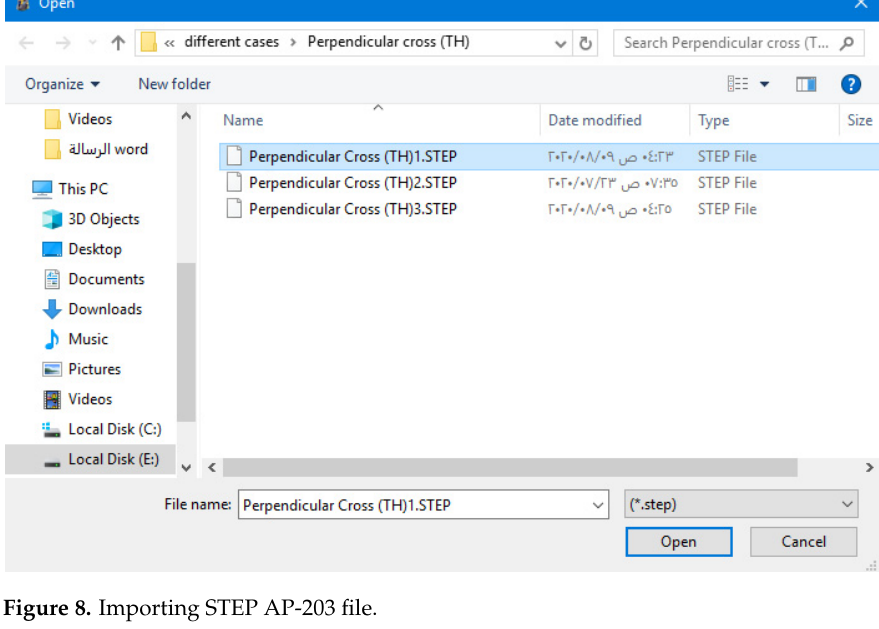
Figure 8. Importing STEP AP-203 file.